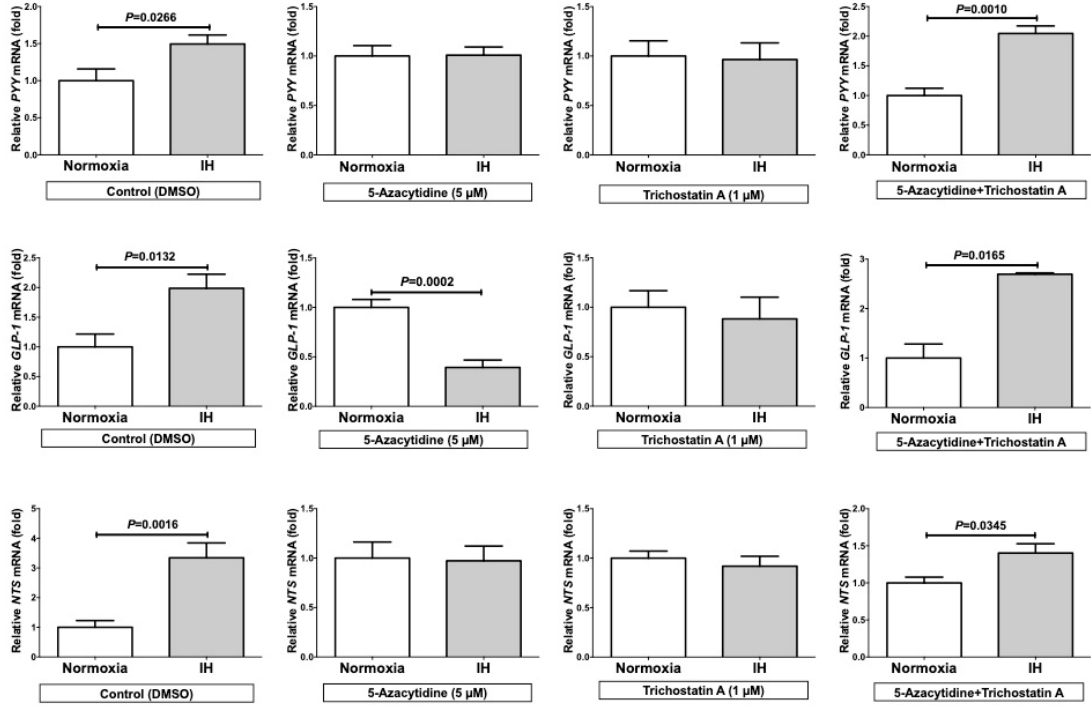
Figure 6. The mRNA levels of PYY , GLP-1 , and NTS under the addition of 5-azacytidine (5AZC), trichostatin A (TSA), and 5AZC + TSA. The addition of TSA only and 5AZC only attenuated the IH-induced up-regulation of PYY , GLP-1 , and NTS . On the other hand, combined addition of TSA + 5AZC recovered the IH-induced up-regulation of PYY , GLP-1 , and NTS mRNA levels in Caco-2 cells. All data are expressed as the mean ± SE for each group ( n = 4–8). The statistical analyses were performed using Student’s t -test.